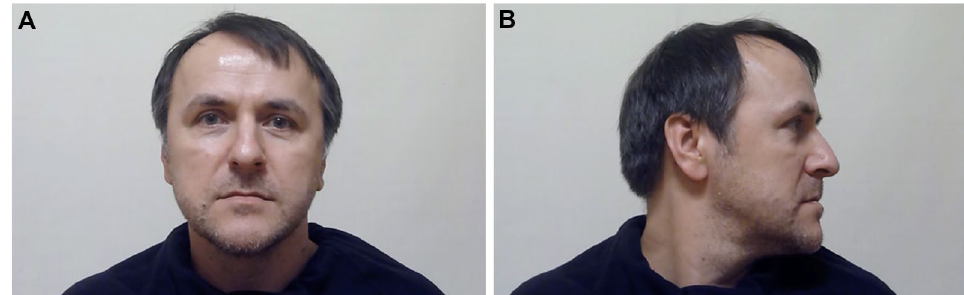
Figure 1. Example of lineup faces from the ( A ) front and ( B ) right-profile. Consent to publish identifying images was